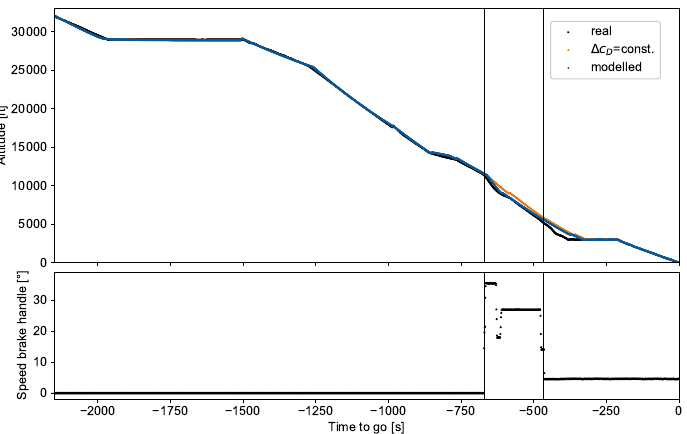
Figure 10. Validation of the developed speed brake model: Comparison of altitude over time of a real B748F flight (black) with modelled flights. Blue: using the aircraft-type-specific speed brake model; orange: assuming ∆ c D = 0.02 and ∆ c L = 0.00. Bottom: the speed brake handle provided by the real flight as FODA data. Vertical lines indicate a time frame (12 min) with significantly deflected speed